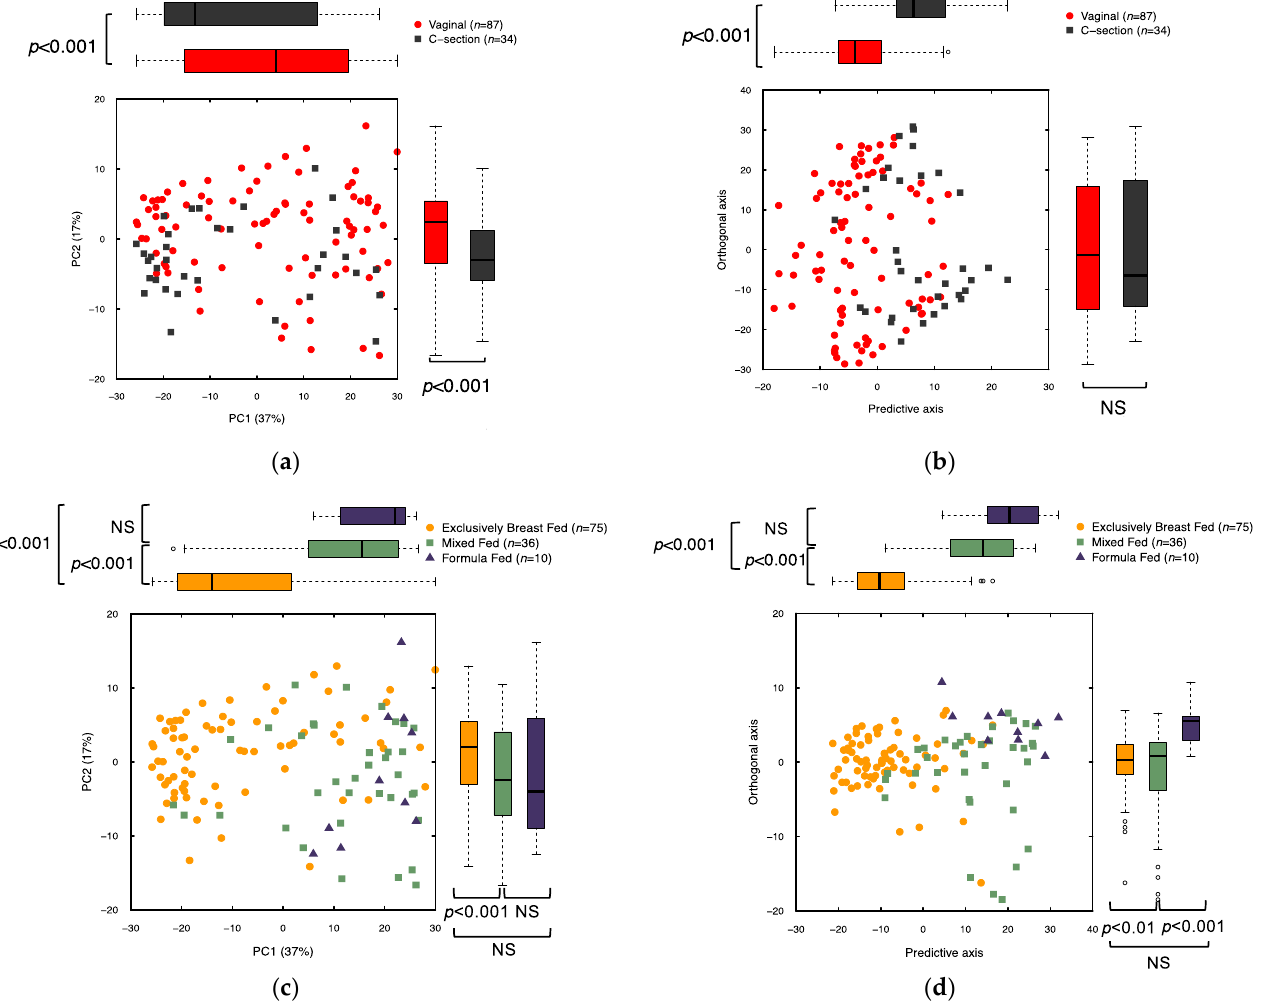
Figure 2. Comparison of stool metabolome between delivery mode and feeding method groups for n = 121 subjects. ( a ) PCA of binned NMR data colored by delivery mode. Number of components = 15, Model statistics: R 2 X = 0.9, Q 2 (cum) = 0.46; ( b ) OPLS-DA of binned NMR data colored by delivery mode. Number of Components = 2 (1 predictive, 1 orthogonal), Model statistics: R 2 X = 0.55, R 2 Y = 0.31, Q 2 (cum) = 0.14; ( c ) PCA of binned NMR data colored by feeding type. Number of